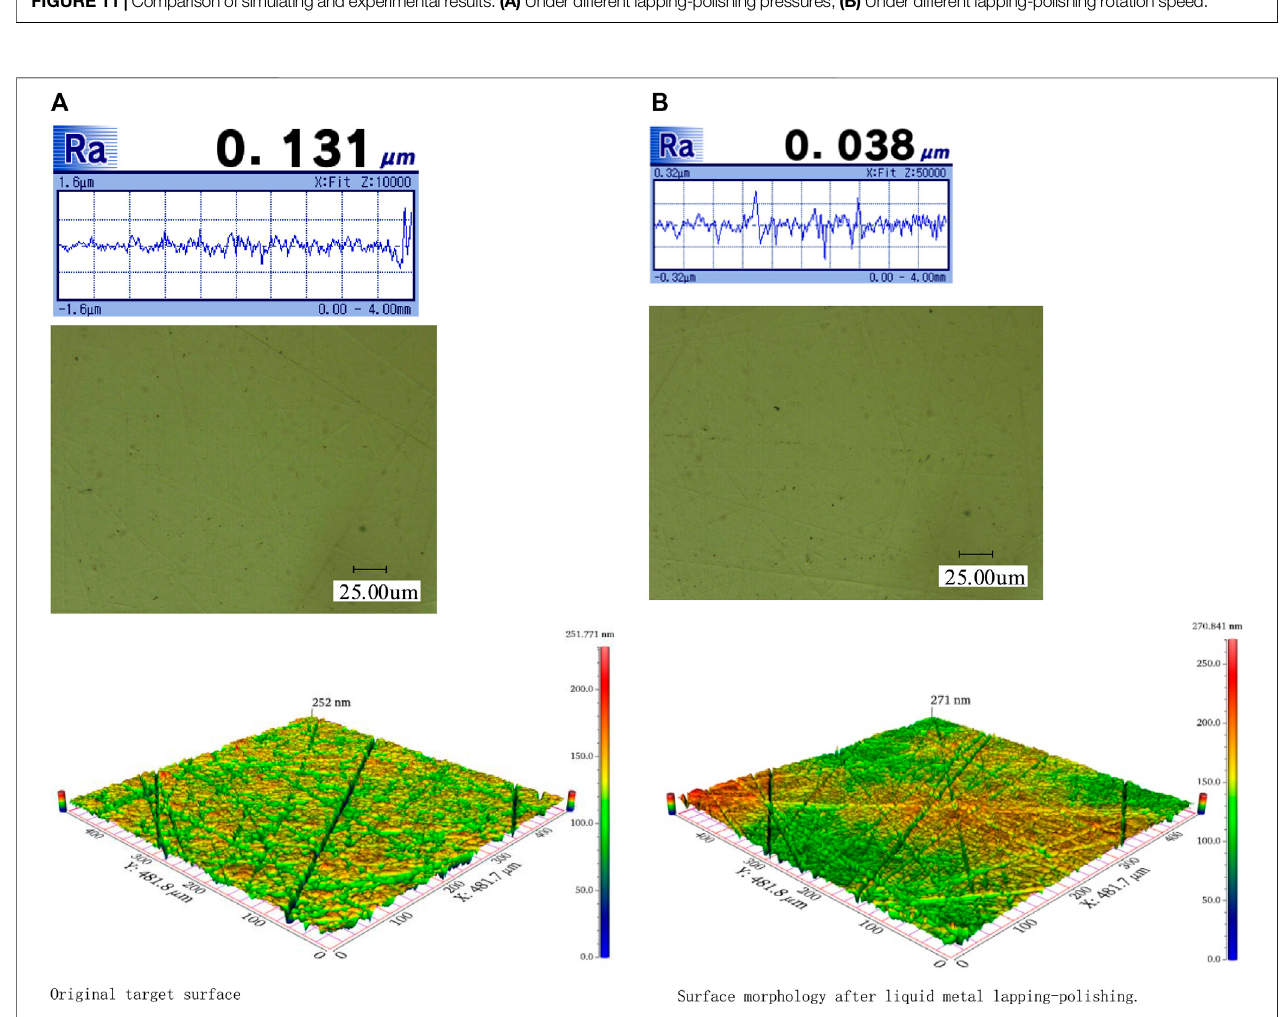
FIGURE 12 | Comparison of surface morphologies before and after liquid metal lapping-polishing. (A) Original target surface, (B) Surface morphology after liquid metal lapping-polishing.